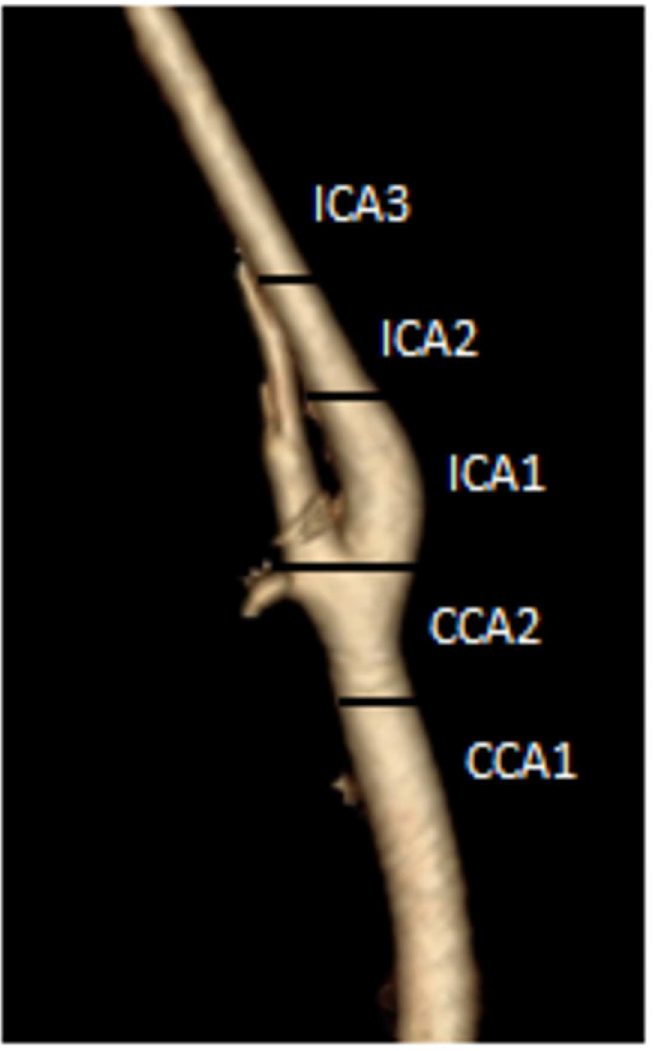
Fig 2. location of lesion. CCA = commoncarotid artery, ICA =